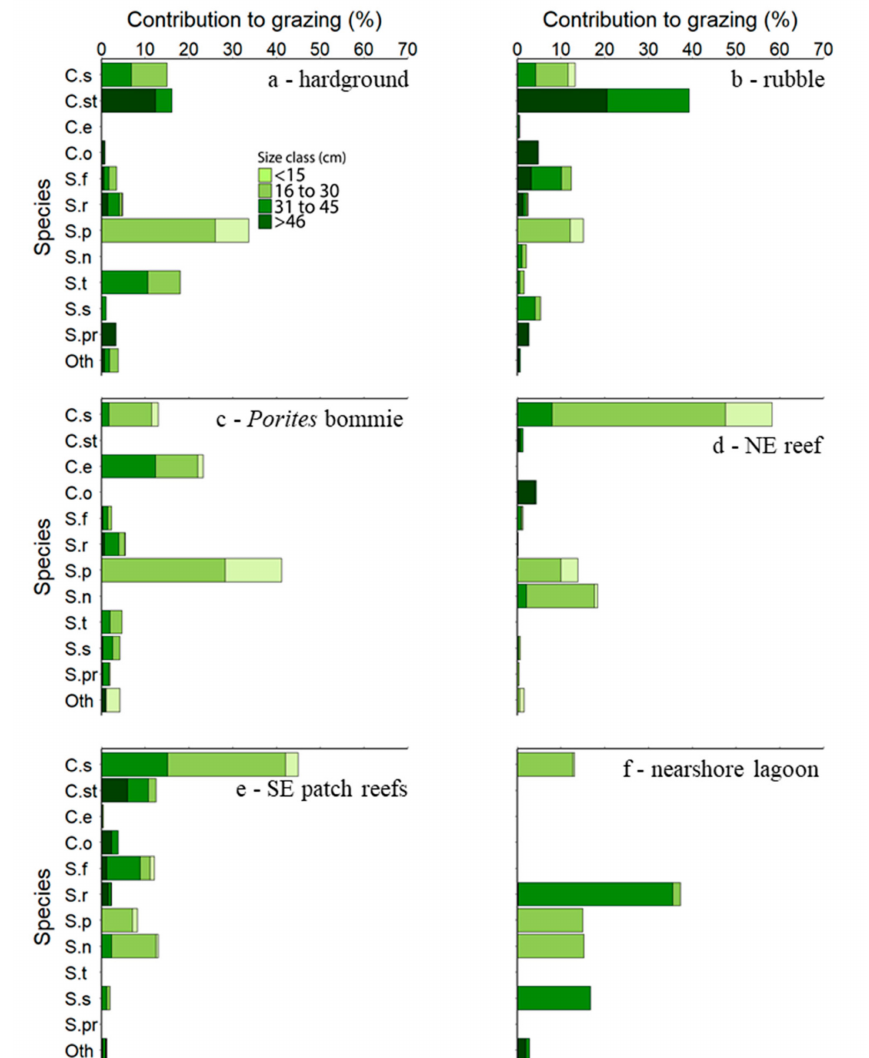
Figure 4. Percent contributions to total grazing by each size class of fifteen parrotfish species present in the six major Vavvaru reef habitats. Species abbreviations: C. s— Chlorurus sordidus , C. st— C. strongylocephalus , C. e— C. enneacanthus , C. o— Cetoscarus ocellatus, S.f— Scarus frenatus, S. r— S. rubroviolaceus, S. p— S. psittacus , S. n— S. niger, S. t— S. tricolor , S. s— S. scaber , S. pr— S. prasiognathos